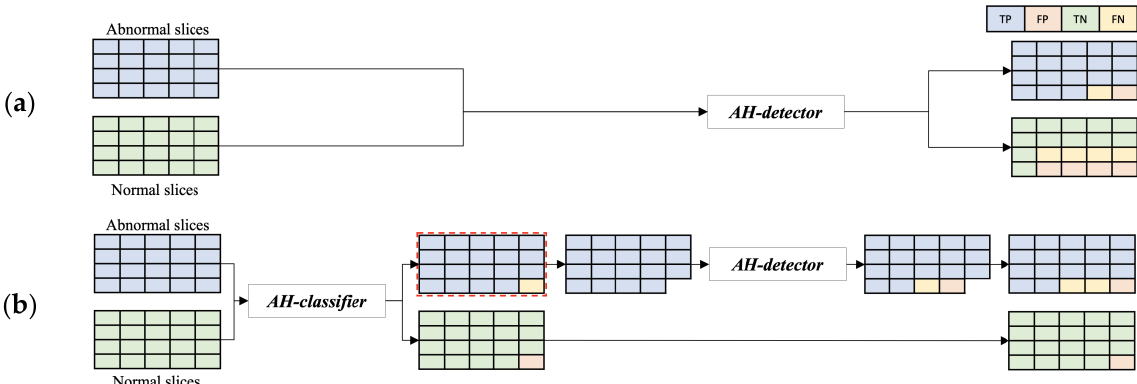
Figure 5. Example comparison of single and cascade model with and without AH classifier placement: ( a ) single model; ( b ) cascade model.